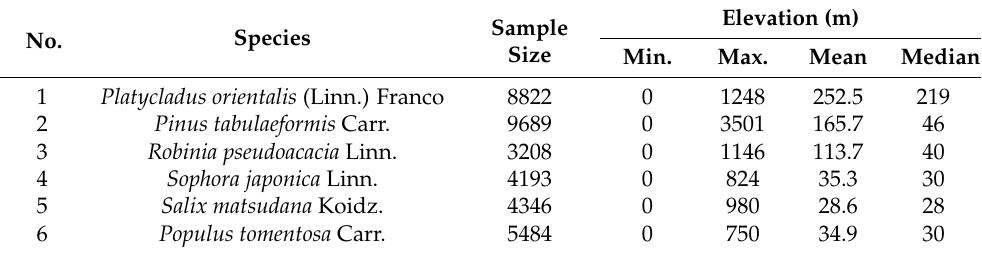
Table 1. Sample sizes and elevation distribution of the main tree species.